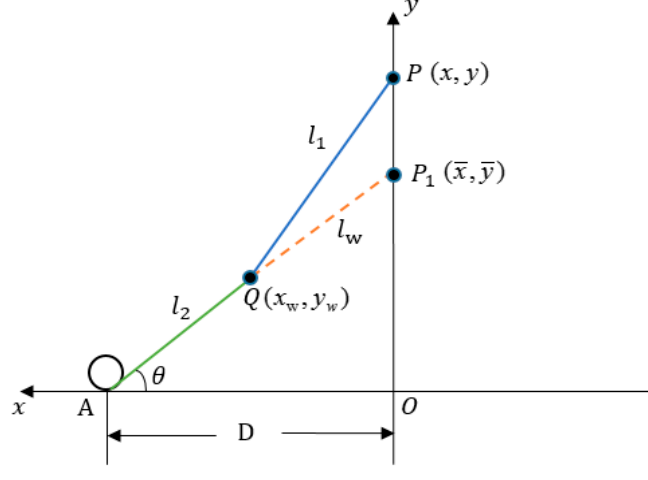
Figure 5. Form of cable in centering arrest.